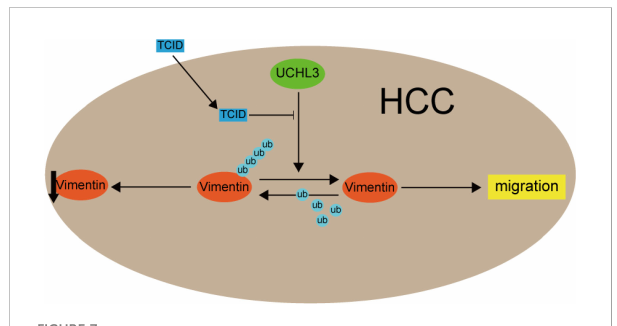
FIGURE 7 A mechanism model fi gure of UCHL3 facilitated HCC cell migration through regulating